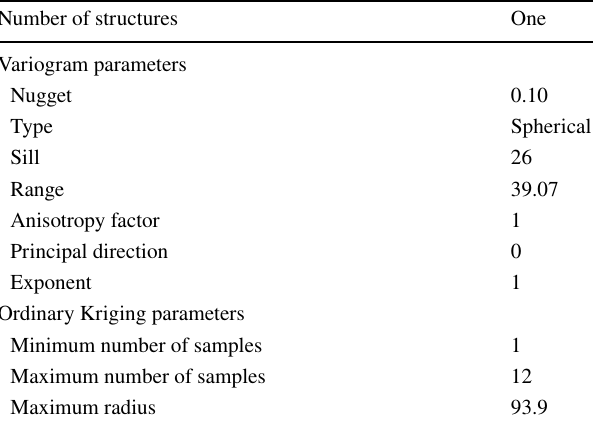
Table 3 Variogram parameters in this study Number of structures